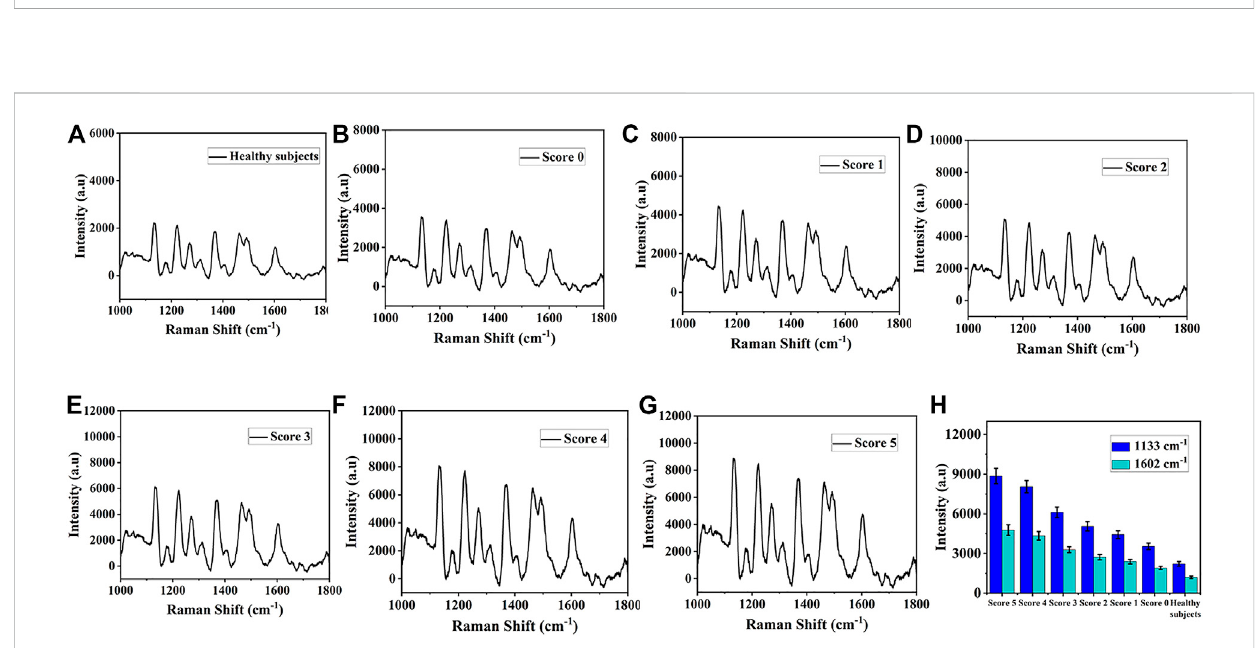
FIGURE 8 TheaverageSERSspectraofmiR-122-5pandmiR-140-5pinserumobtainedfrom (A) Healthysubjects (B) Score0, (C) Score1, (D) Score2, (E) Score 3, (F) Score 4, and (G) Score 5. (H) Corresponding SERS intensities at 1,133 cm − 1 and 1,602 cm − 1